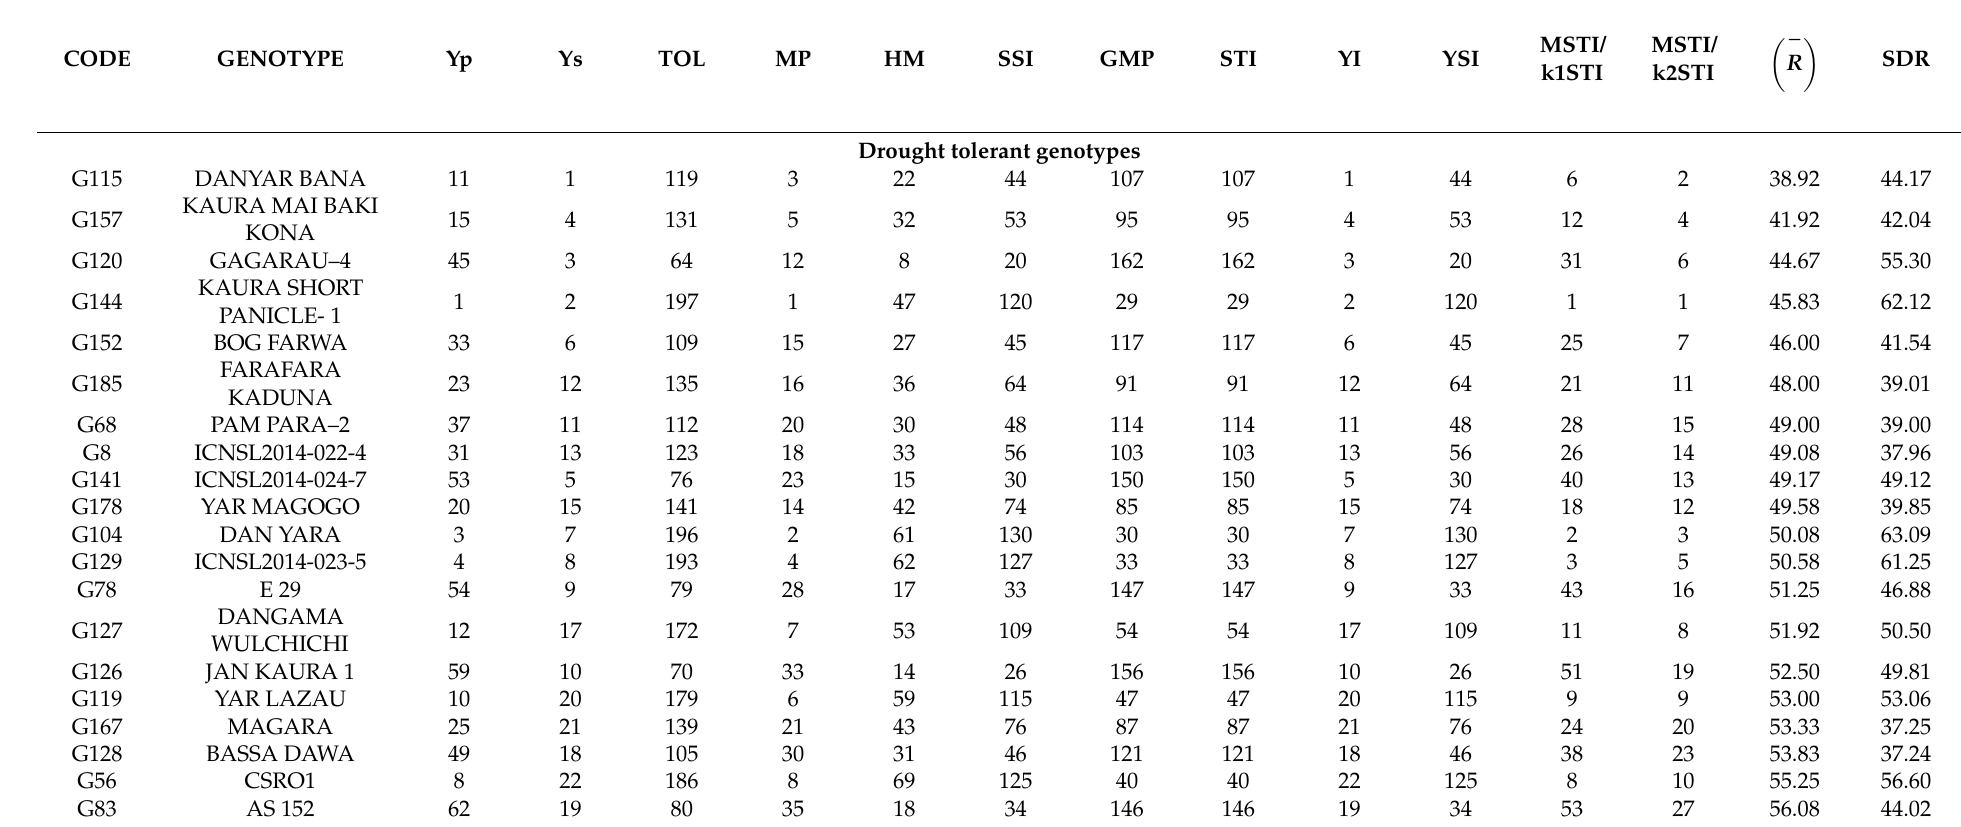
(cid:0) (cid:1) R Table 5. Rank, rank mean , and standard deviation of ranks (SDR) of drought resistance/tolerance indices of the sorghum genotypes